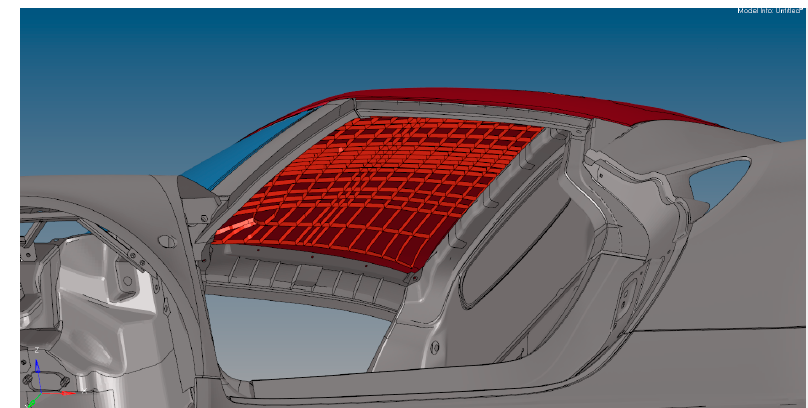
Figure 16. PP23CF optimized car roof—bottom view.